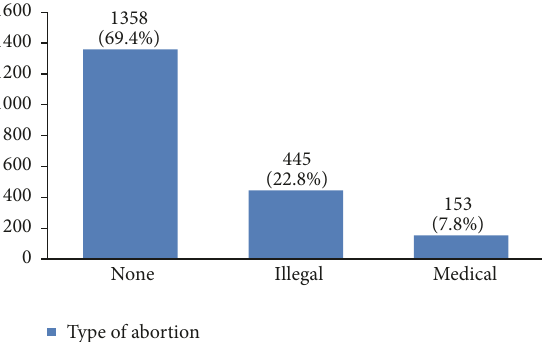
Figure 11: The hormone consumption of the studied breast cancer